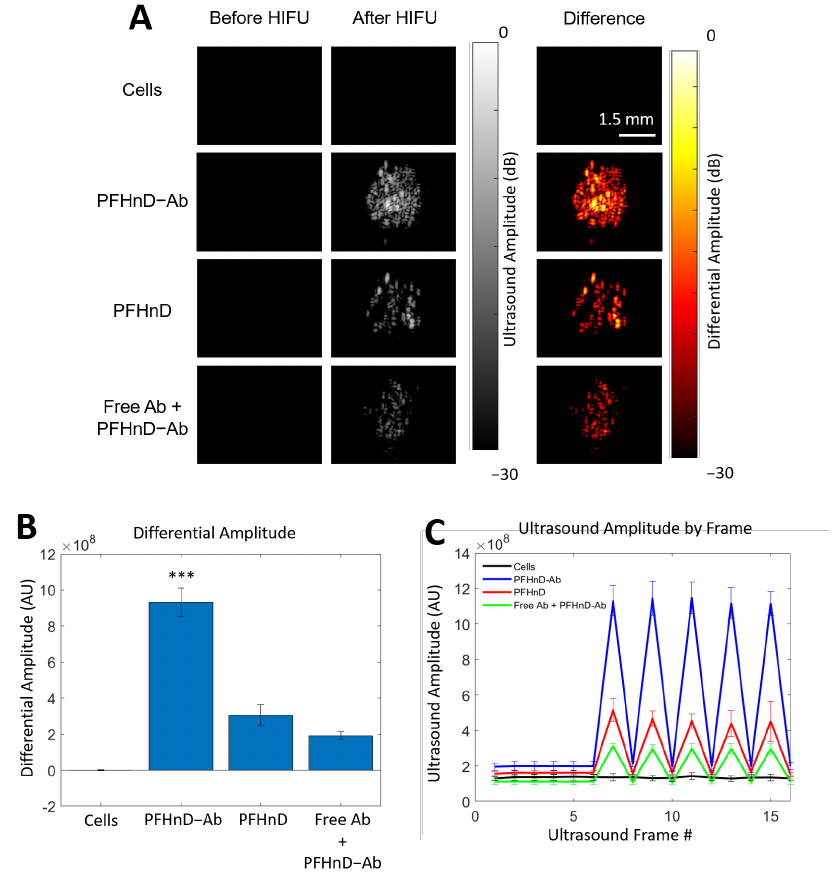
Figure 6. Ultrasound images of cells embedded in polyacrylamide tissue-mimicking phantoms before and after the HIFU activation of the PFHnDs. ( A ) The difference between the two images is displayed in the right panel, indicating PFHnD activation. Cells conjugated with the targeted droplets (PFHnD-Ab) were imaged along with the control groups; non-targeted droplets (PFHnD), blocking group (Free antibody and PFHnD-Ab), and FaDu cells without PFHnDs. ( B ) The differential amplitude was calculated for each of the groups and resulted in the PFHnD-Ab group having a significantly higher differential amplitude (*** p < 0.001) than the other groups. ( C ) The average ultrasound amplitude within the focal spot for each ultrasound frame captured for each of the groups. The HIFU was pulsed prior to frames 7, 9, 11, 13, and 15, resulting in the ultrasound amplitude spike within those